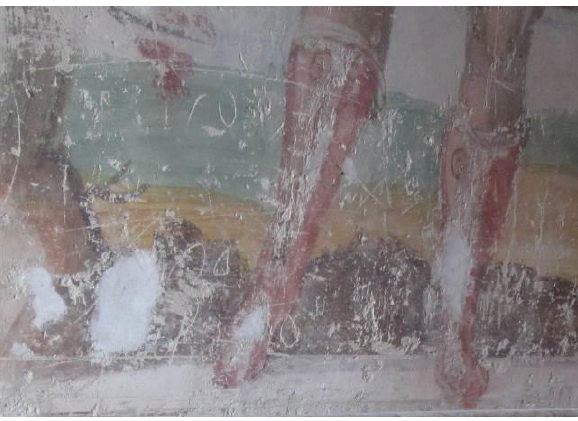
Figure 15: Wall paintings decay, room